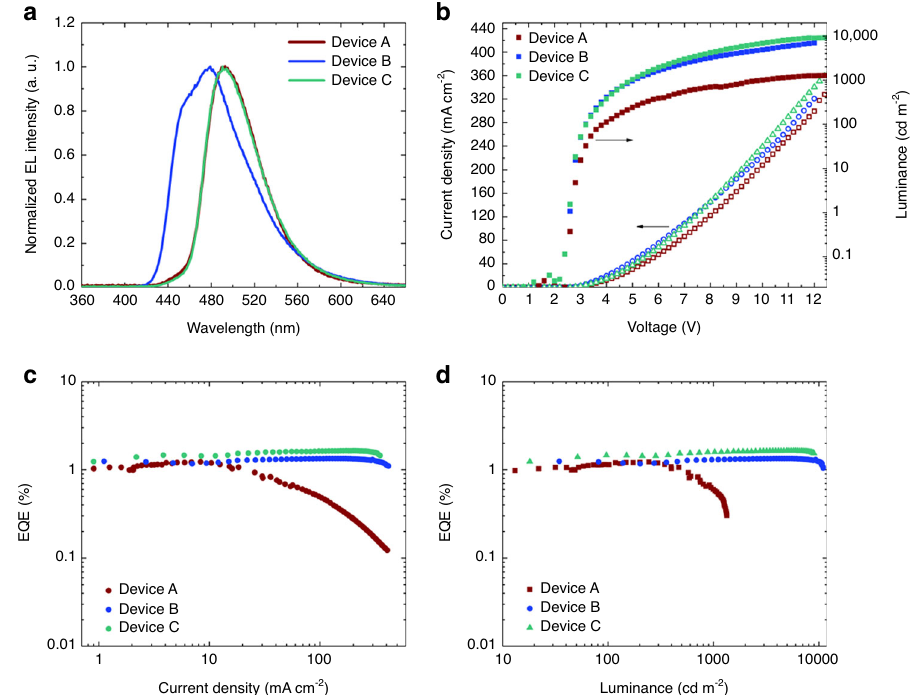
Fig. 4 Comparison of OLED performance. a EL spectra shows similar spectrums for devices A and C as the emission comes from DCNP emitter without signi fi cant shoulder peak of residual emission from host which suggests that ef fi cient FRET from host to guest. b current density – voltage and luminance – voltage curves showing current density in all devices are approximately similar whereas signi fi cant decrement of luminance can be observed in device A due to severe STA. c EQE – current density curves showing serious EQE rolloff of device A at higher current densities comparing to devices B and C. d EQE – luminance curves showing maximum output luminance of device A is limited around 1200 cd m − 2 while EQE is dropping down due to STA, whereas devices B and C show maximum output luminance around 10,000 cd m − 2 with no serious EQE rolloff until the devices break down due to joule